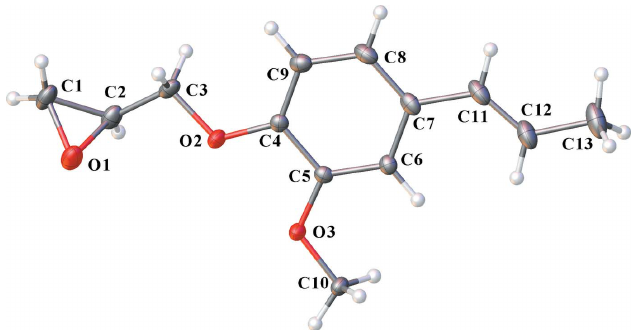
Figure 3 Stacking representation of GE-isoEu viewed down the a axis (colour code: C dark grey, O red, H white; Mercury representation; Macrae et al. ,